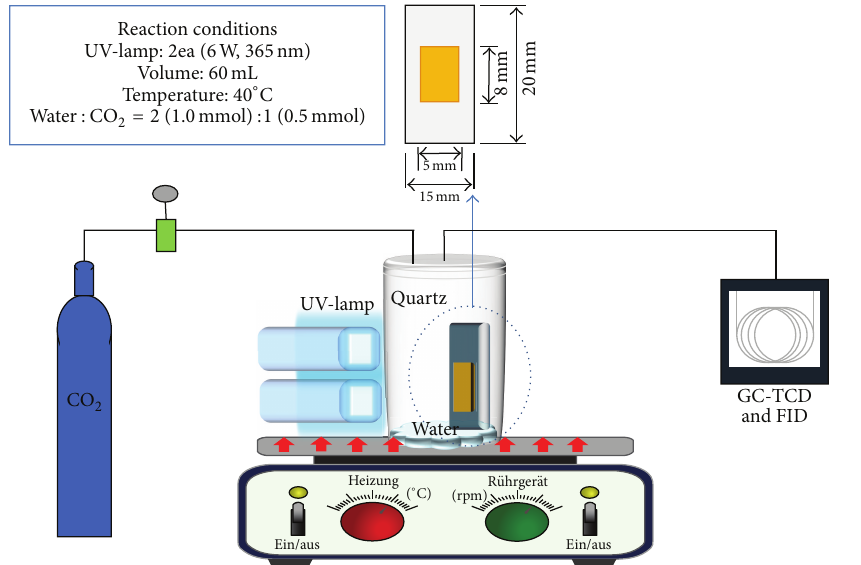
Figure 1: Batch type photoreactor used for CO 2 photoreduction to CH 4